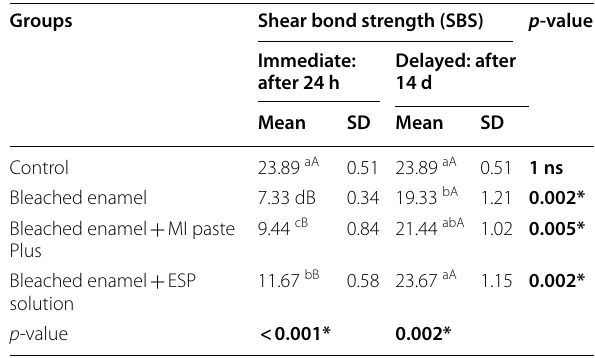
Mean values with the same capital letters at the same row reveal non-significant difference Mean values with the same small letters at the same column reveal non- significant difference ns; non-significant ( p > 0.05), *; significant ( p < 0.05)